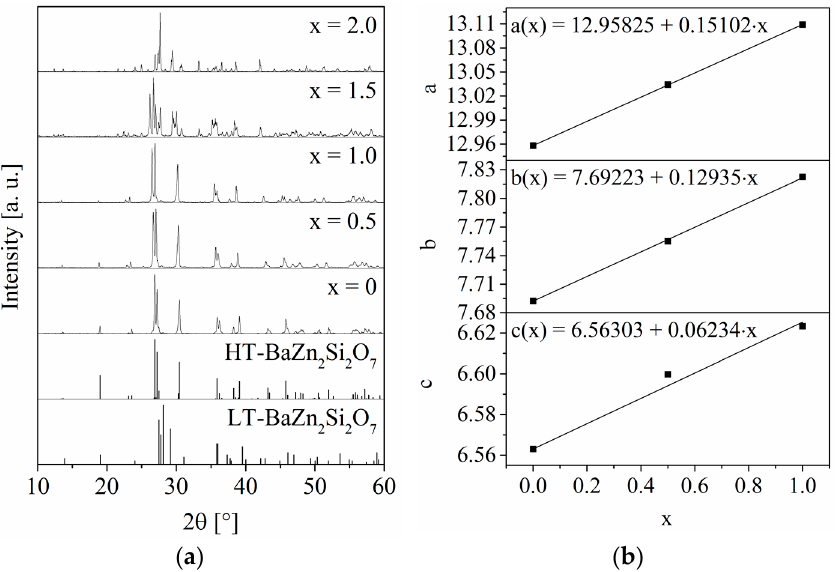
Figure 1. Results from X ‐ ray diffraction (XRD) recorded at room temperature. ( a ) XRD patterns within the solid solution series Ba 0.5 Sr 0.5 Zn 2 Si 2 ‐ x Ge x O 7 with different values of x are shown. In the lower part, the theoretical peak positions of crystals with the structure of high ‐ temperature (HT) ‐ and low ‐ temperature (LT) ‐ BaZn 2 Si 2 O 7 taken from references [3,11] are displayed; ( b ) the lattice parameters of Ba 0.5 Sr 0.5 Zn 2 Si 2 ‐ x Ge x O 7 are shown as a function of x. The values for x = 0 were taken from reference [9].